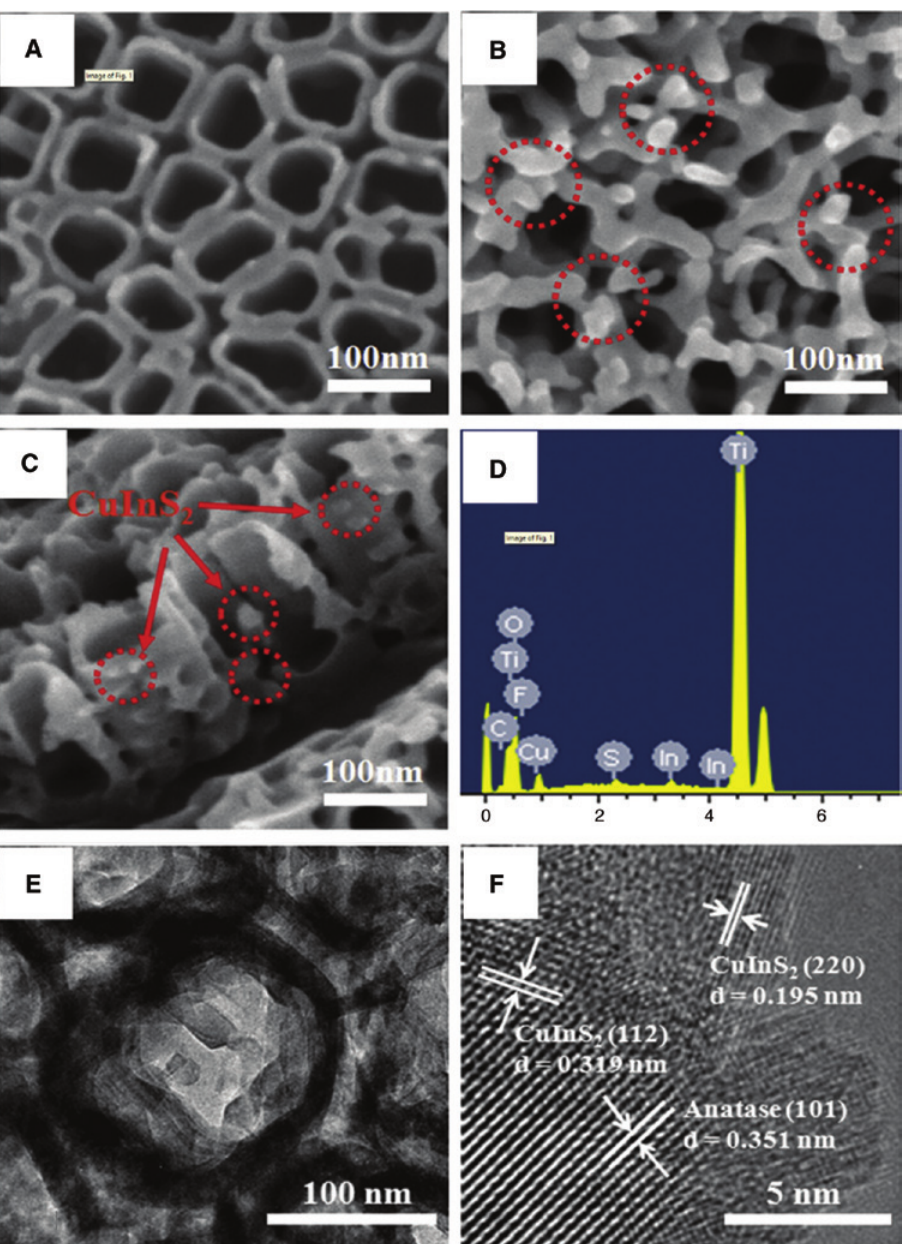
NTAs (A). Top view (B), side view images (C), and EDX spectra (D) of CuInS Figure 15: SEM image of TiO 2 images of CuInS /TiO NTAs. Reproduced from Ref. [194] with permission. Copyright Elsevier. 2 2